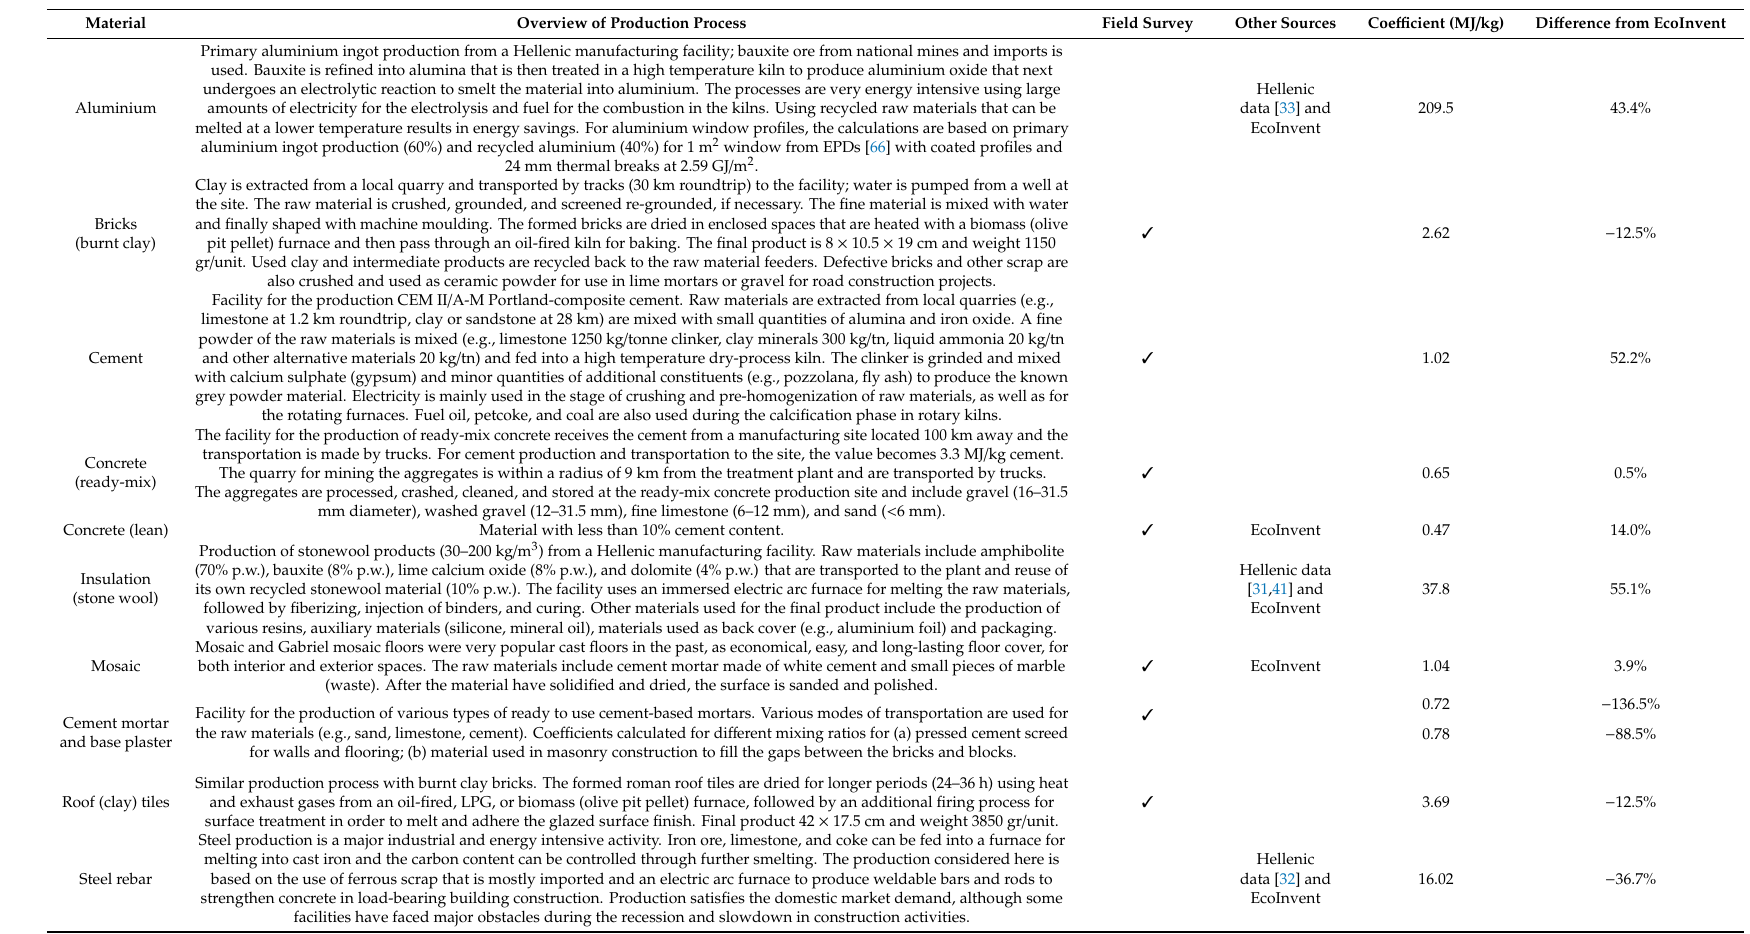
Table 3. Production processes and derived embodied energy coe ffi cients (MJ / kg) in the Hellenic dataset from the field surveys (cradle-to-gate) or calculated from other Hellenic data sources using